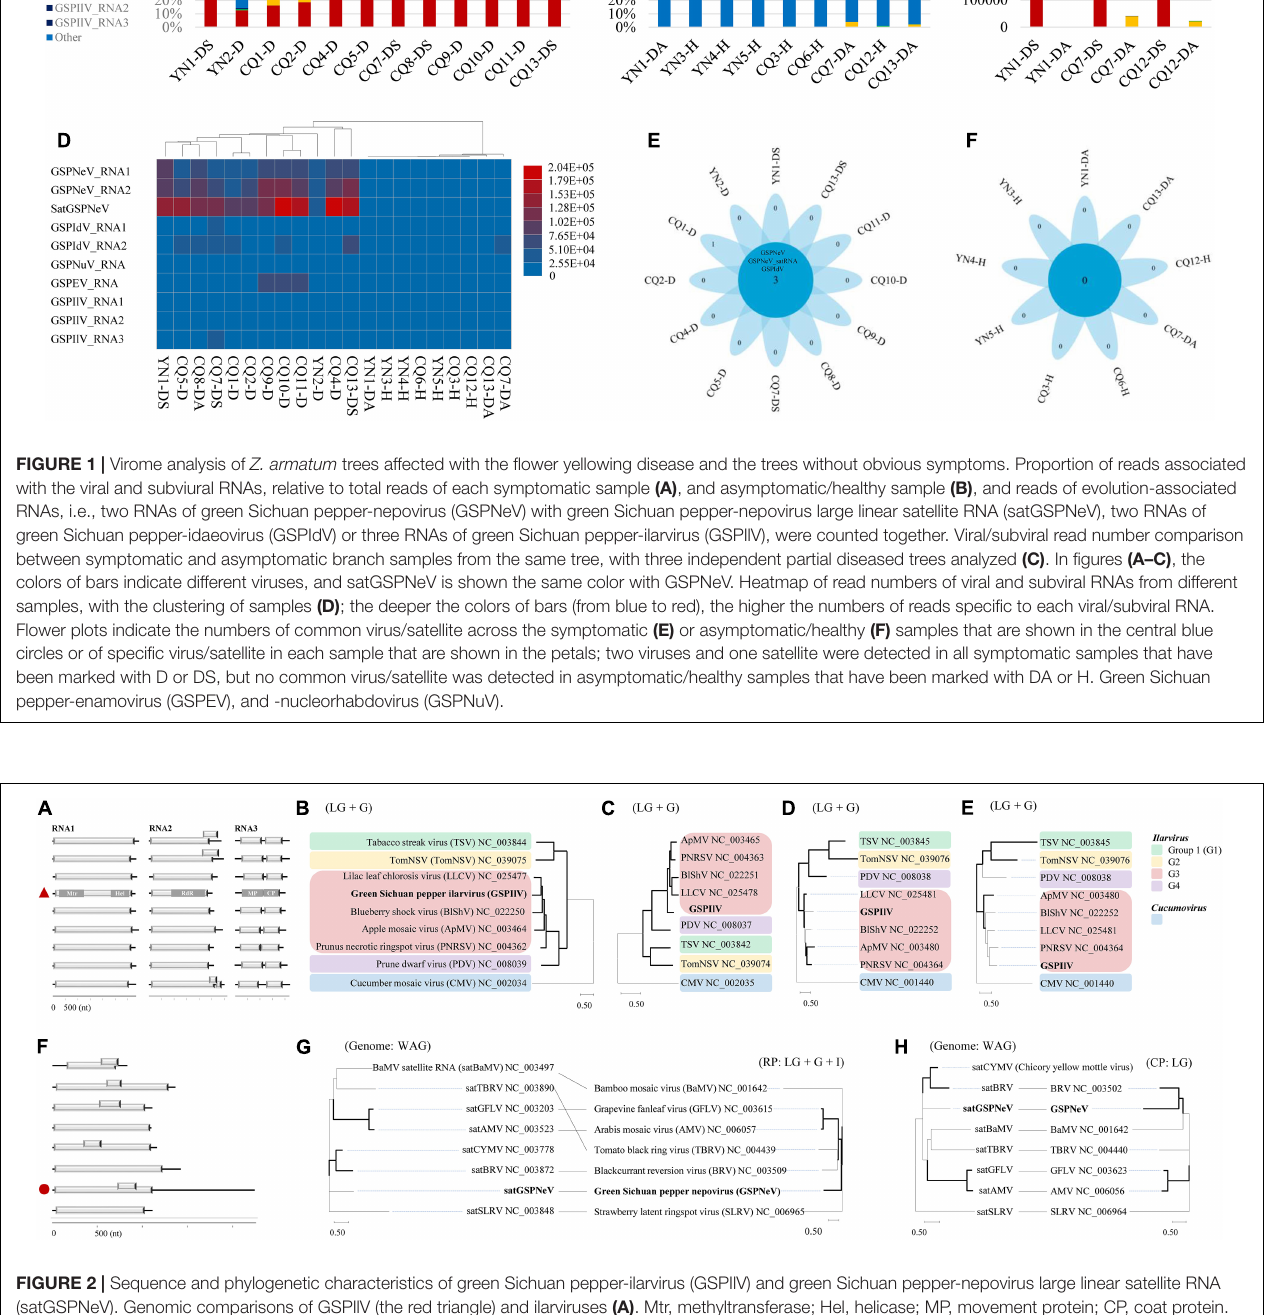
Frontiers in Microbiology |